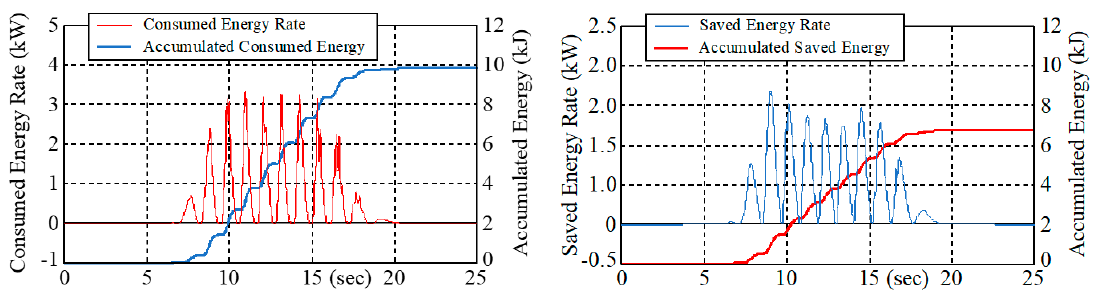
Figure 34. Consumed and saved energy on slalom course (ccc = 0.7).